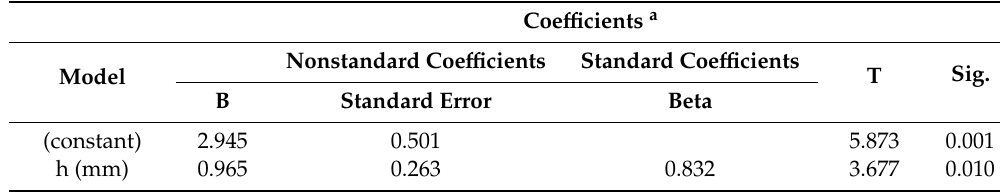
Table 11. Linear regression coe ffi cients: Wheel-tracking test and topographic